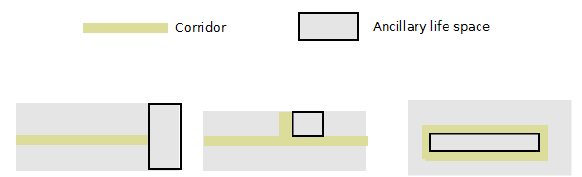
Figure 16. Typical layouts of ancillary life